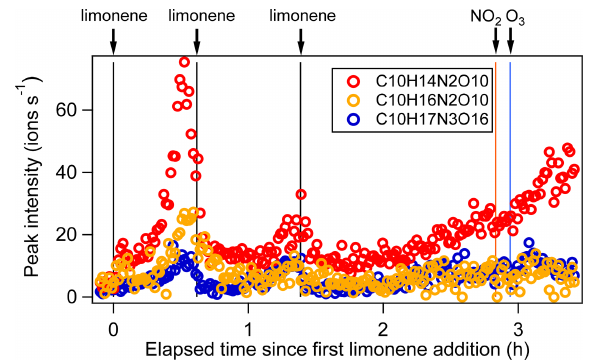
Figure 4. Time series of peak intensity of several monomers C 10 H 14 N 2 O 10 , C 10 H 16 N 2 O 10 , and C 10 H 17 N 3 O 16 as the repre- sentatives of multiple N monomers during the periods P1 to